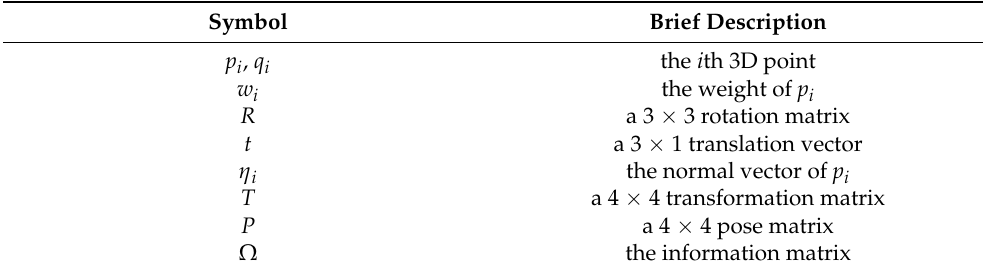
Table 1. Some of the symbols used in this section and their brief